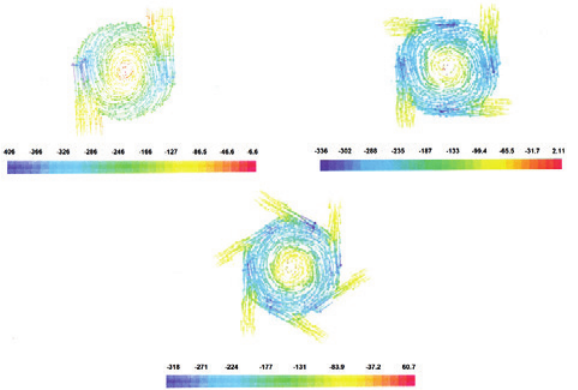
Figure 10. Velocity vectors for vortex tubes with two, four and six inlet nozzles